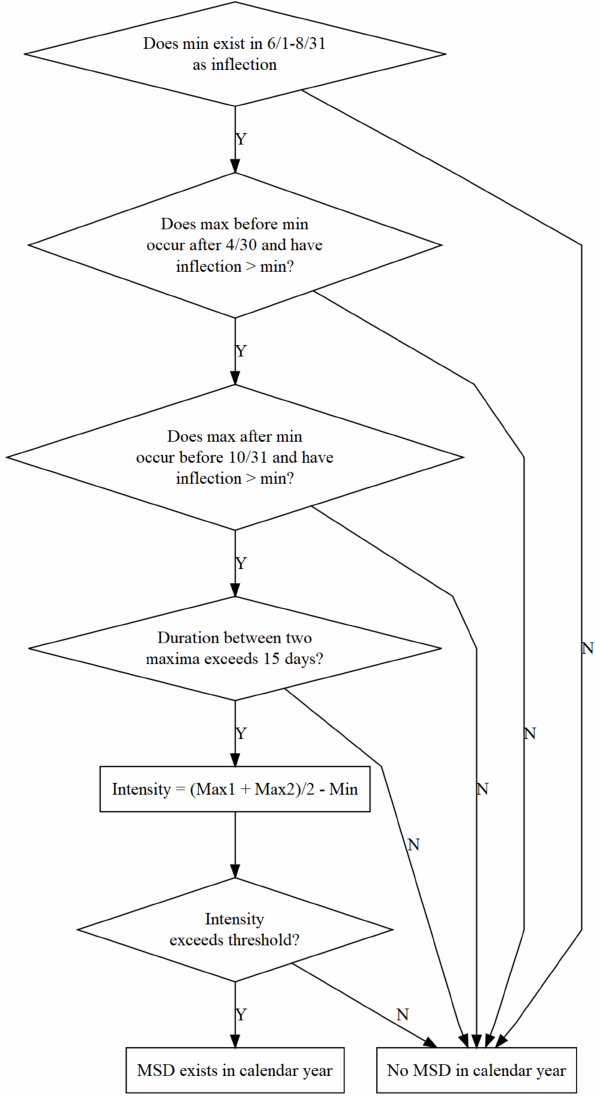
Figure 1. The steps used to determine for each calendar year whether a location experiences an